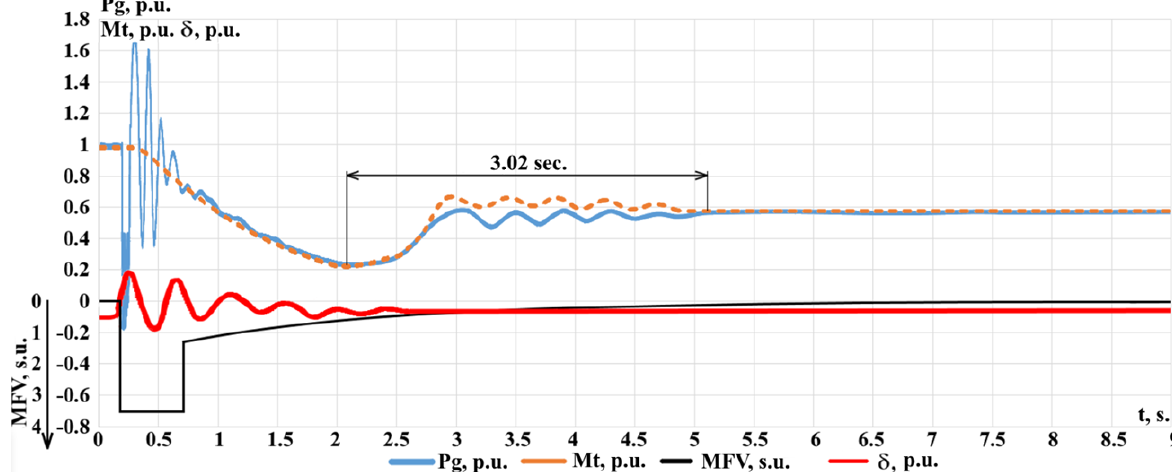
Figure 20. Generator G 2 active power, turbine torque, and angle for the Case 2.